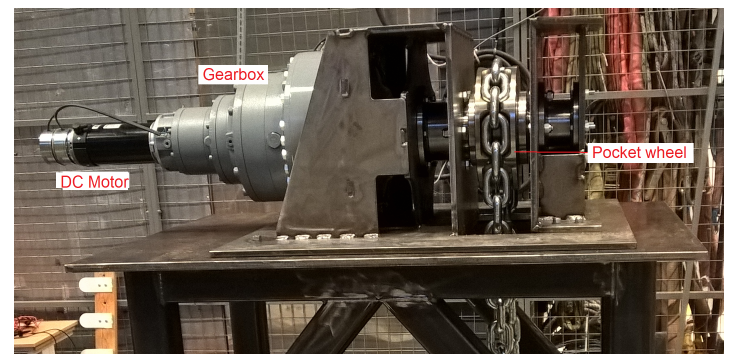
Figure 1. The winch system consists of a gearbox, a DC motor, a steel chain, and a pocket wheel. The pitch diameter of the pocket wheel is 0.32 m.